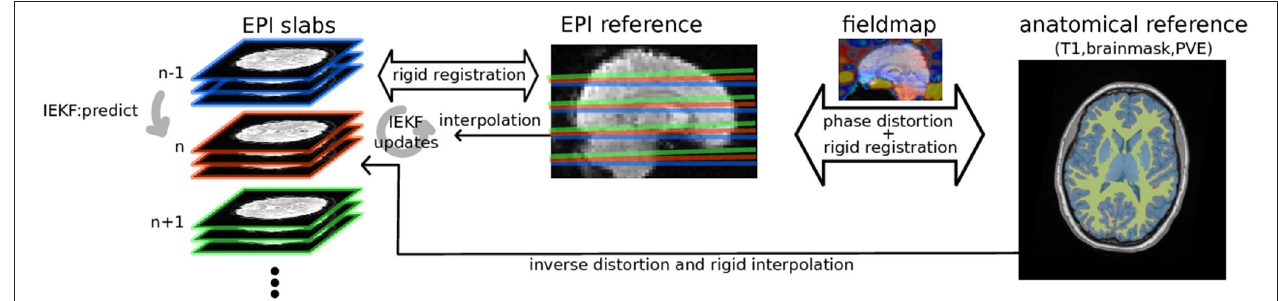
FIGURE 1 | Diagram of the algorithm: EPI groups of slices are sequentially rigidly registered by IEKF to the EPI reference initialized by previously estimated position, while concurrently removing an intensity bias using prior information (mask, partial volume effect map) from anatomical segmented anatomical scan while taking into account distortions estimated from B0